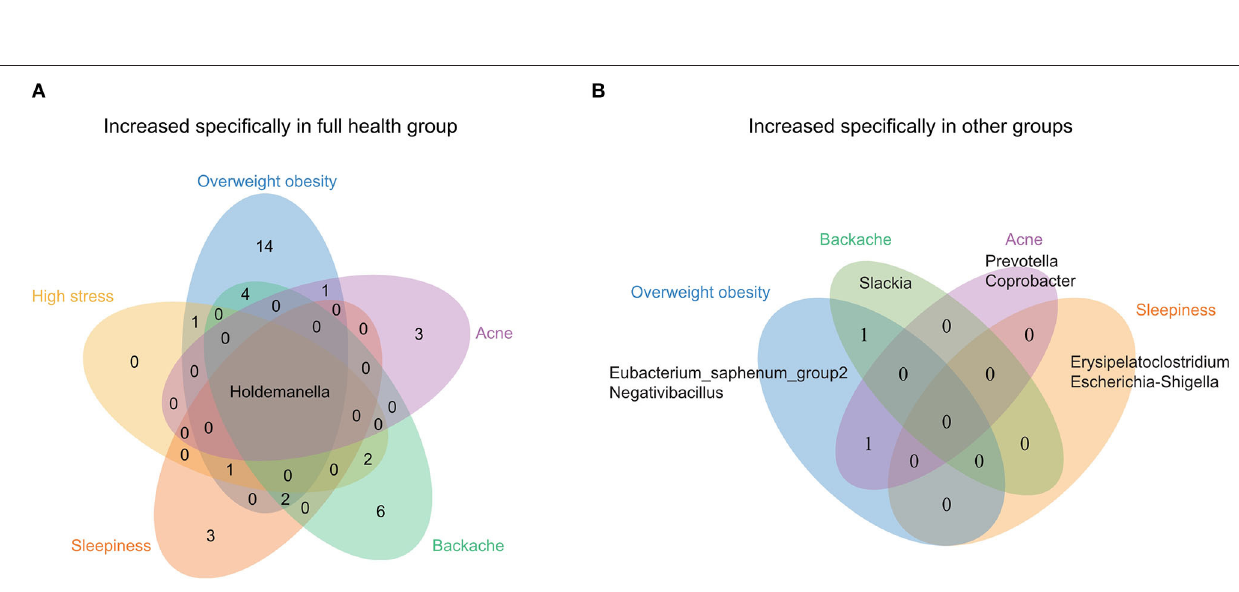
Frontiers in Nutrition | www.frontiersin.org